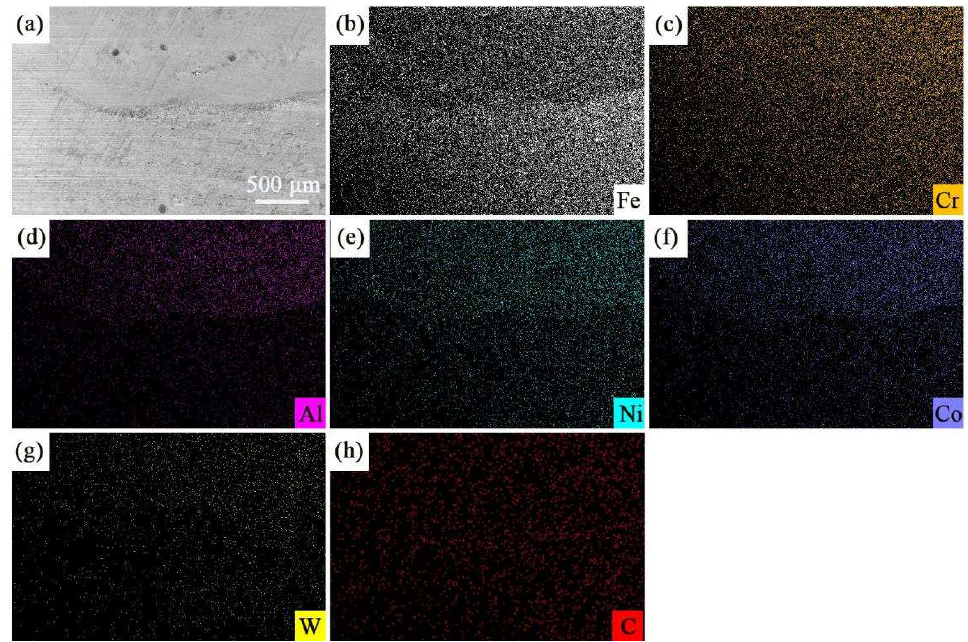
Figure 6. Elemental mapping pictures of the AlCoCrFeNi/WC coating section; ( a ) SEM image of the section and elements of ( b ) Fe, ( c ) Cr, ( d ) Al, ( e ) Ni, ( f ) Co, ( g ) W and ( h ) C.